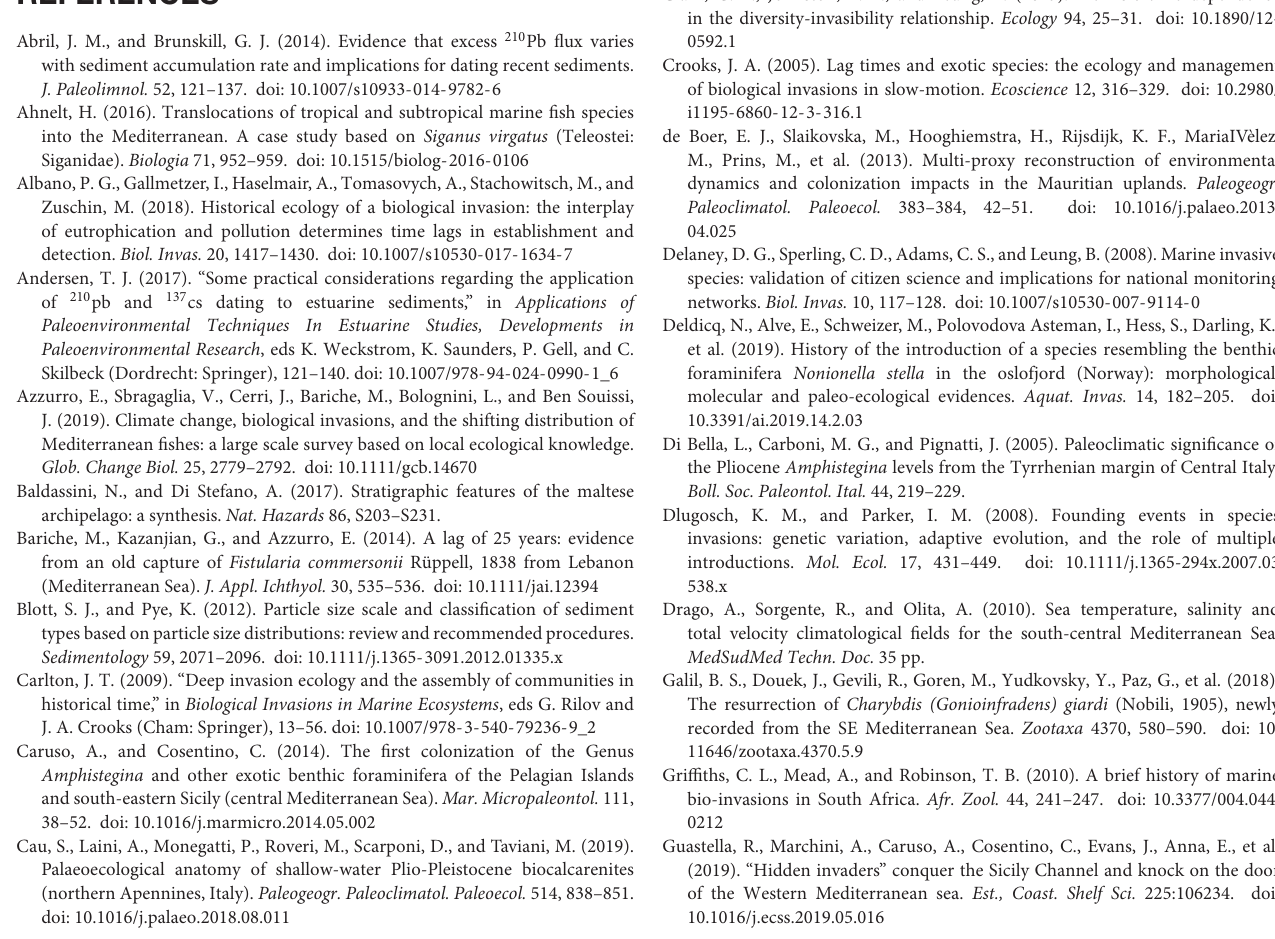
Supplementary Table 1 | Geographic coordinates and other sampling details of the study sites.